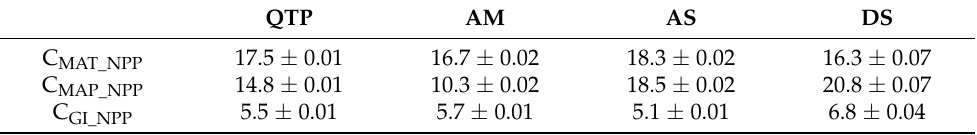
Figure 6. Relative contributions of ( a ) MAT, ( b ) MAP, and ( c ) GI to the NPP interannual variation estimated by generalized linear models (GLMs). ( d ) Spatial pattern of the dominant variables, which was displayed by RGB composite (MAT: red; MAP: green; and GI: blue). Table 3. Means ( ± SE) of the relative contributions (%) of mean annual temperature (C MAT_NPP ), mean annual precipitation (C MAP_NPP ), and grazing intensity (C GI_NPP ) to NPP variation estimated by generalized linear model (GLM) across the entire QTP and within alpine meadow (AM), alpine steppe (AS), and desert steppe (DS).